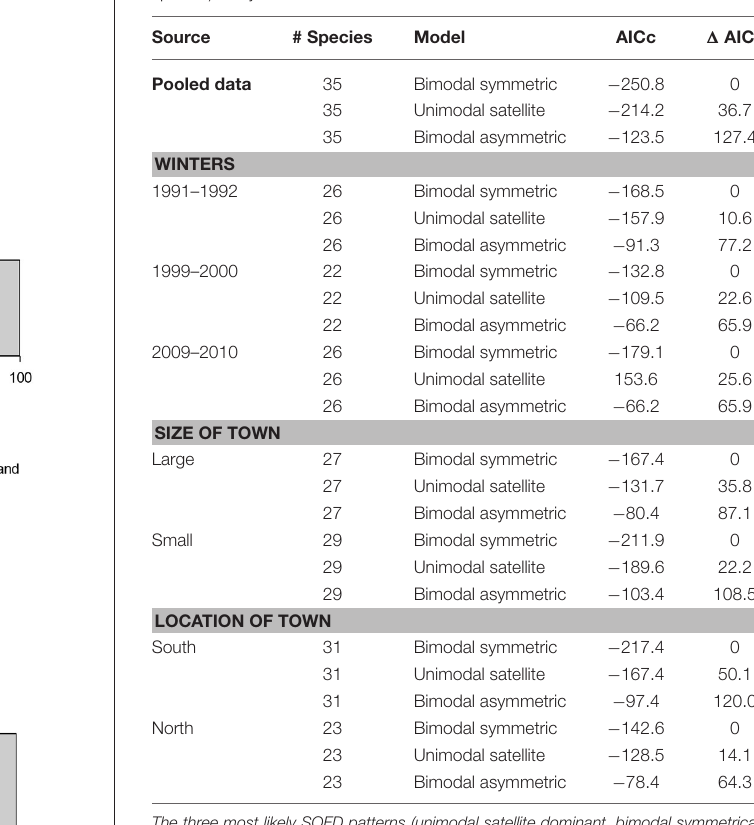
TABLE 2 | The results of urban wintering bird species SOFD (core–satellite species)